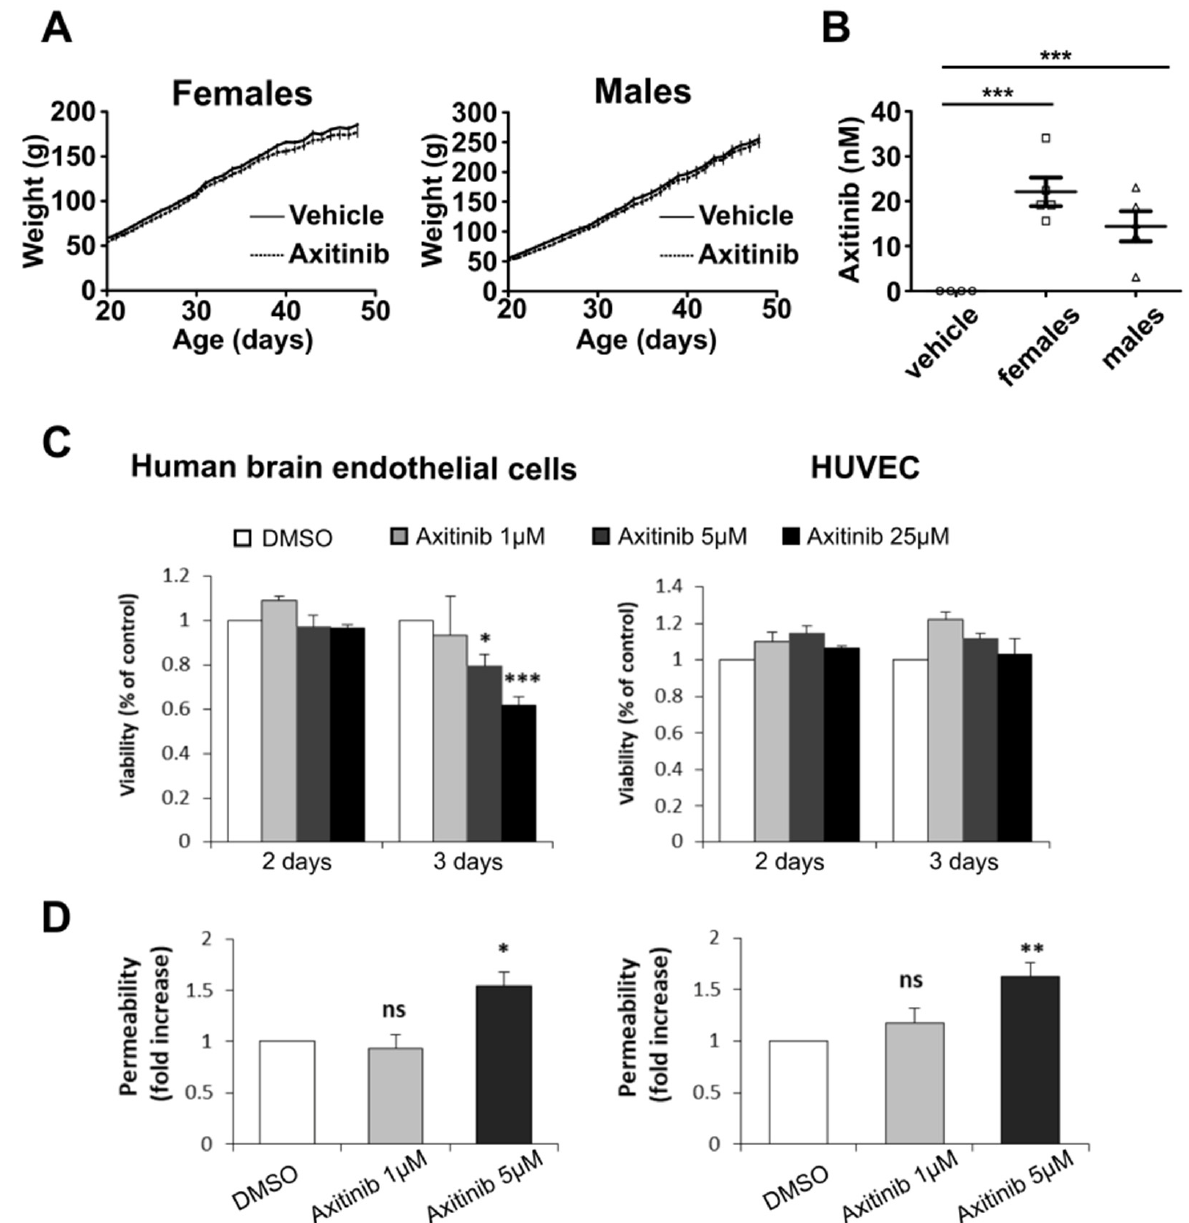
Figure 3. Axitinib shows no major chronic toxicity and can pass the blood–brain barrier of juvenile mammals. ( A ) Growth curves of female and male 20-day-old Wistar rats treated with axitinib (50 mg/kg/day) for 28 days (datapoints represent the mean weight ± SEM, n = 5 rats per group). ( B ) Dot plots representing the measurements of axitinib concentrations in rat cerebella after 28 days of axitinib (50 mg/kg/day) or vehicle alone treatments ( n = 5 cerebella per group, bars represent the means ± SEM). ( C ) MTT assay analysis of axitinib toxicity towards human brain endothelial (BEC) and human umbilical vein endothelial cells (HUVEC). ( D ) Relative permeability of human brain endothelial cells and HUVEC in an in vitro endothelium permeability assay. Note: * p < 0.05, ** p < 0.01, *** p < 0.001, one-way ANOVA test.